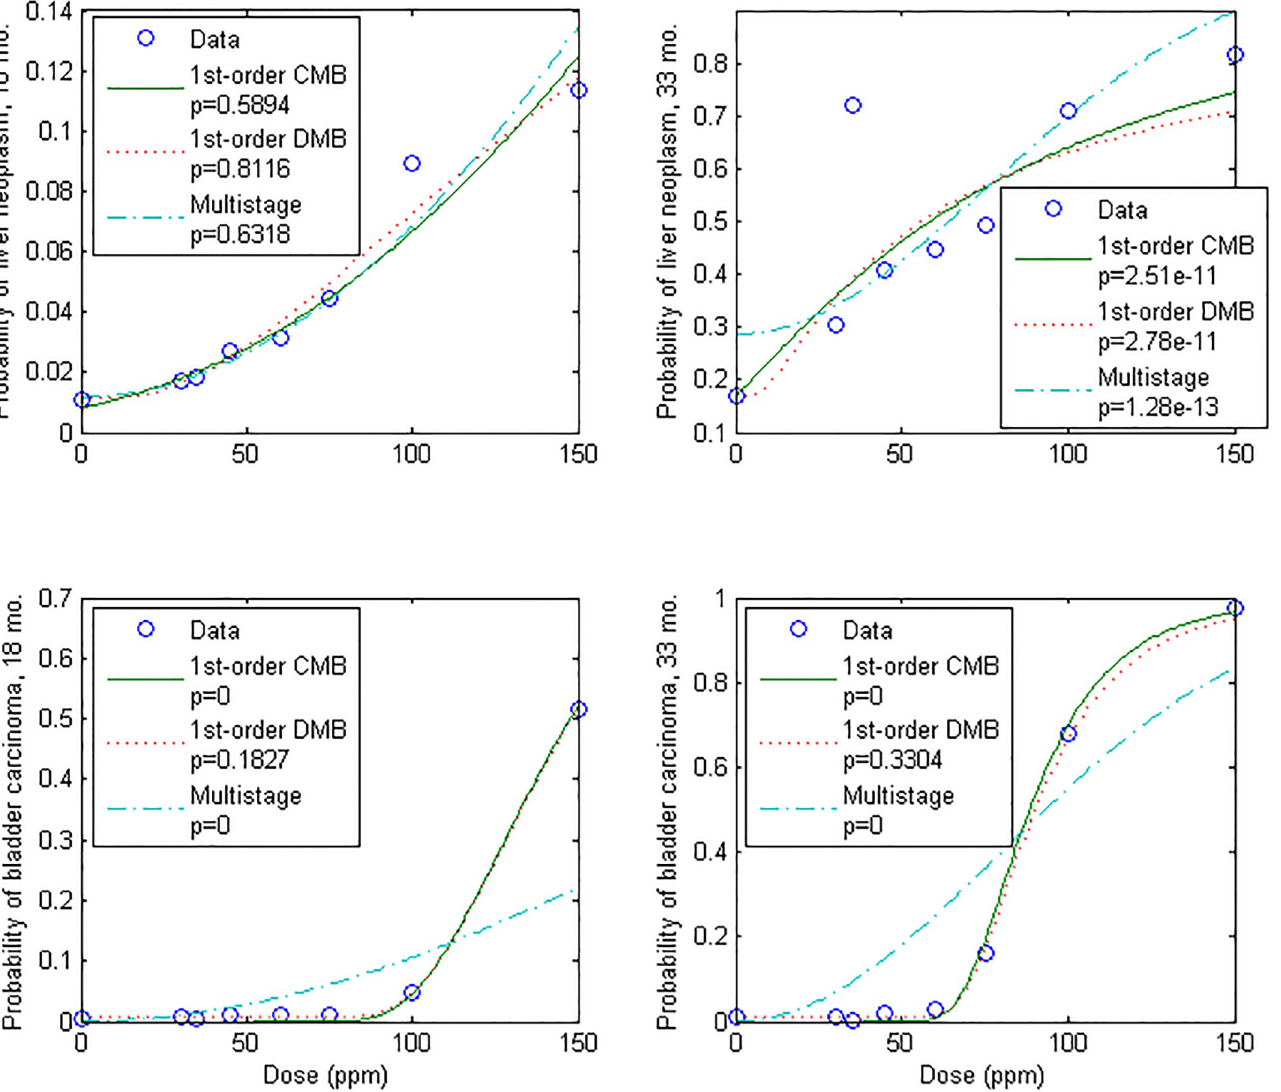
Fig 5. First-order/dissimilar-mode background (DMB), first-order/common-mode background (CMB), and two-stage DRFs versus data on 2-acetylaminofluorene-induced liver neoplasms and bladder carcinomas at 18 and 33 months, in mice. (p = 0 denotes a p -value below machine precision).